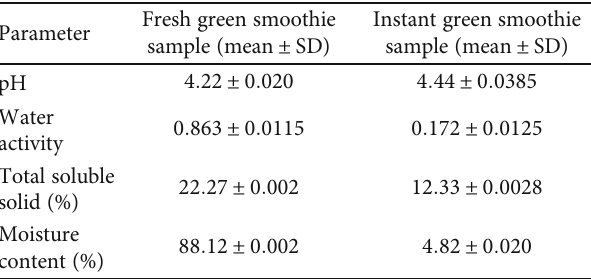
Figure 2: The radar chart corresponding to the sensory analysis of developed instant green smoothie powder. This chart indicates the mean rank of appearance, color, odor, texture, taste, aftertaste, and overall acceptability for the developed instant green smoothie powder. A red color line indicates the actual likeness, a purple color hachure line indicates the 75% likeness, and a blue hachure line indicates the 50% likeness for the developed instant green smoothie Table 1: Physiochemical properties (pH, water activity, total soluble solid, and moisture content) of fresh green smoothie and instant green smoothie sample.